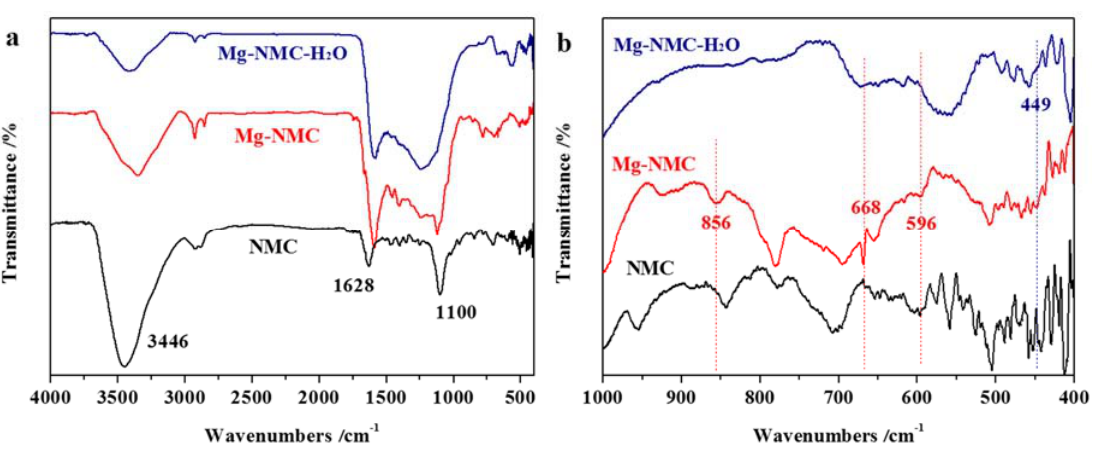
Figure 2. FT-IR spectra ( a , b ) of NMC, Mg-NMC and Mg-NMC-H 2 O.